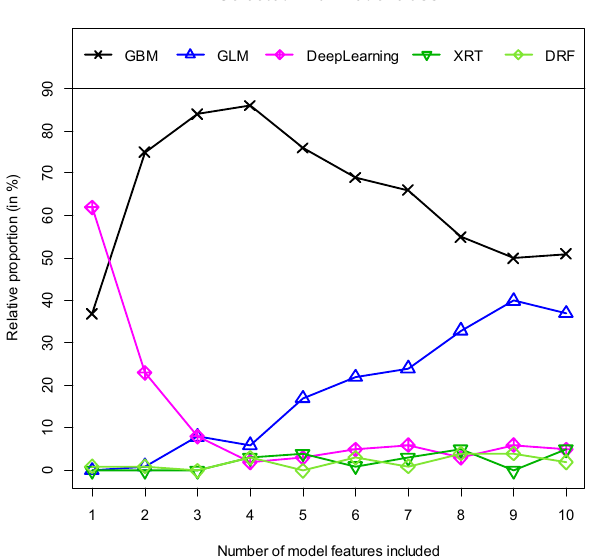
Figure 4. Selected final model class. GBM Gradient Boosting Machine, GLM Generalized Linear Model, DeepLearning = Fully-connected multi-layer artificial neural network, XRT Extremely Randomized Trees, DRF Distributed Random Forest.